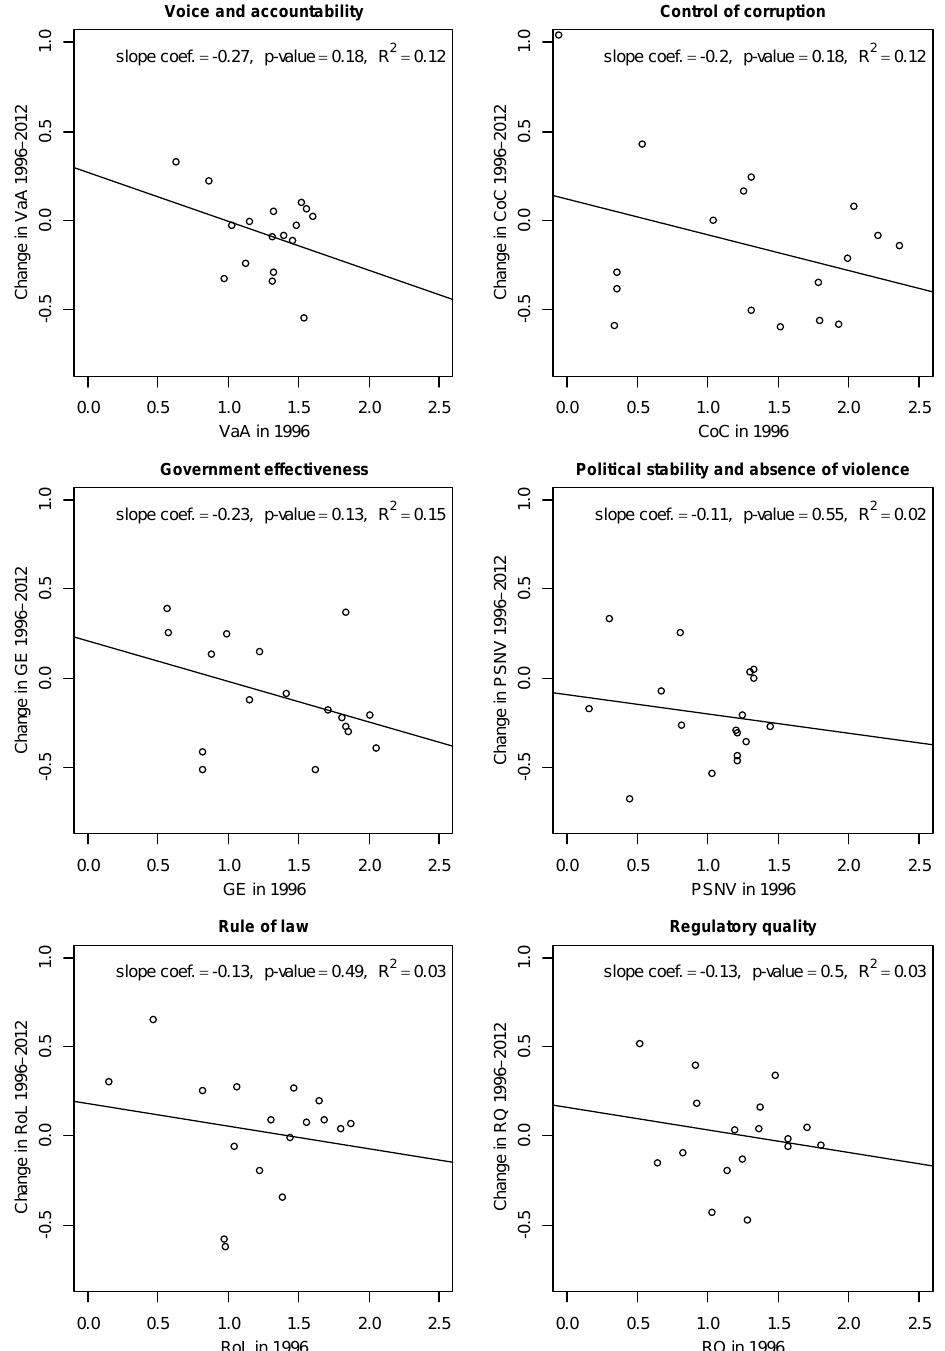
Figure 5 : WGIs’ β -convergence in the euro